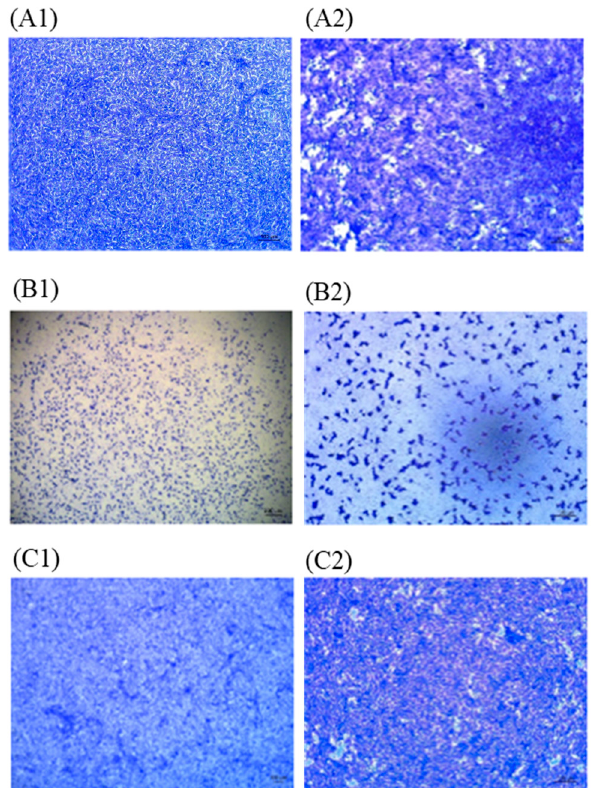
Figure 1. Microscopy image of vero monolayers. Vero cells were inoculated with nasopharyngeal swab. (A) Vero cell cultures in negative control. 40 × ( A1 ), 200 × ( A2 ) micrograph. (B) Vero cell cultures in positive control. 40 × ( B1 ), 200 × ( B2 ) micrograph. (C) Microscopy image of Vero cells inoculated with nasopharyngeal swab sample of a patient 33 days after diagnosis. No cytopathic e ff ect was seen. 40 × ( C1 ), 200 × ( C2 ) micrograph. Virus stock used for positive control was obtained from the Centers for Disease Control and Prevention (KCDC, Seoul, Korea), the virus titer was 2.2 × 10 5 PFU / mL and the Ct value was 11 (KCDC03